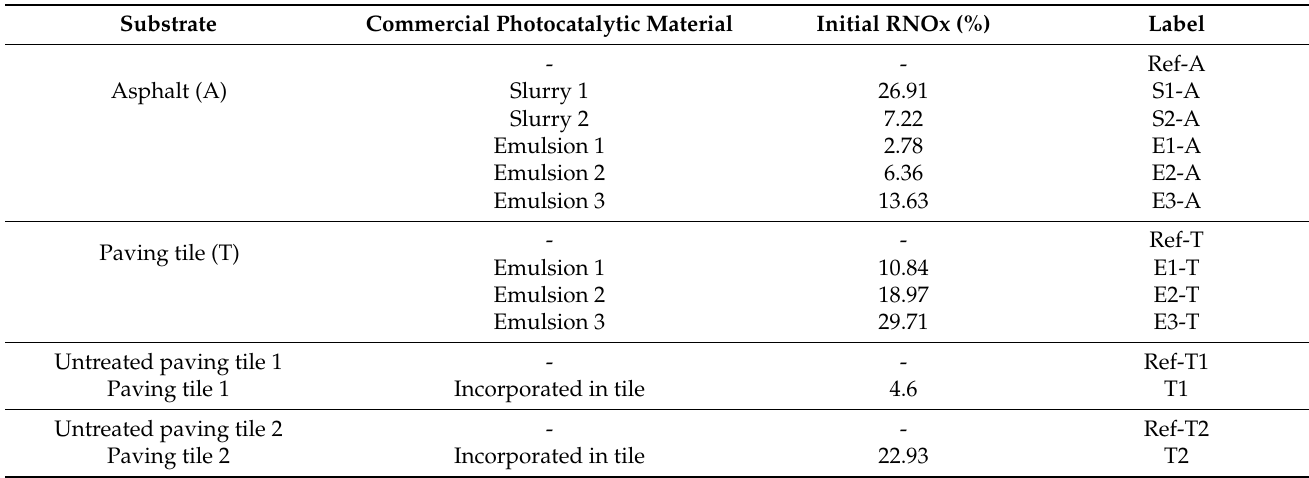
Table 1. Material description and